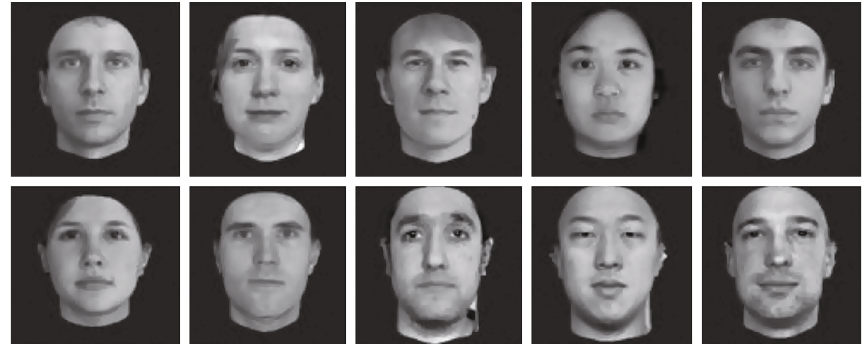
Figure 1: Sample of Subject in the MIT (2003-2005) database.